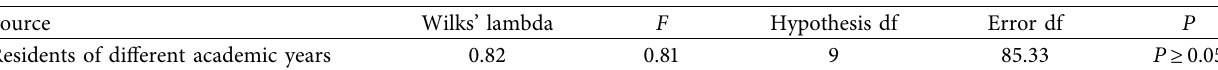
Table 4: Multivariate analysis of variance test results of the difference between residents of different academic years in the research help- seeking subscale table.